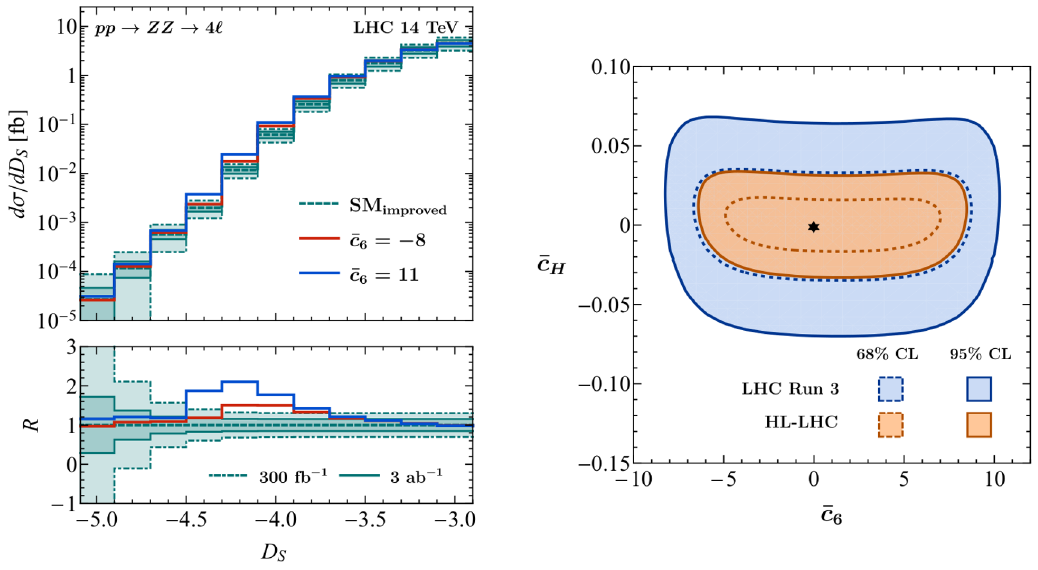
Figure 6. Left: QCD-improved D S distributions for pp → ZZ → 4 ‘ . The SM spectrum (dashed green) and BSM predictions for ¯ c 6 = − 8 (solid red) and ¯ c 6 = 11 (solid blue) are shown. The uncer- tainty bands around the SM spectrum indicate the total uncertainties expected at LHC Run 3 and HL-LHC. Right: projected 68% and 95% CL constraints in the ¯ c 6 – ¯ c H plane at LHC Run 3 (dashed and solid blue) and HL-LHC (dashed and solid red). The black star represents the SM prediction. For additional details see main